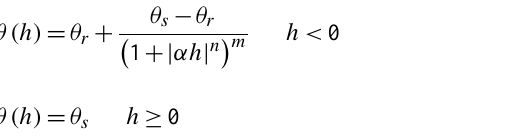
Fig. 8. Values of (a) θ 3 and (b) h 3 , observed, fitted and predicted with ARMA(1,1) model.